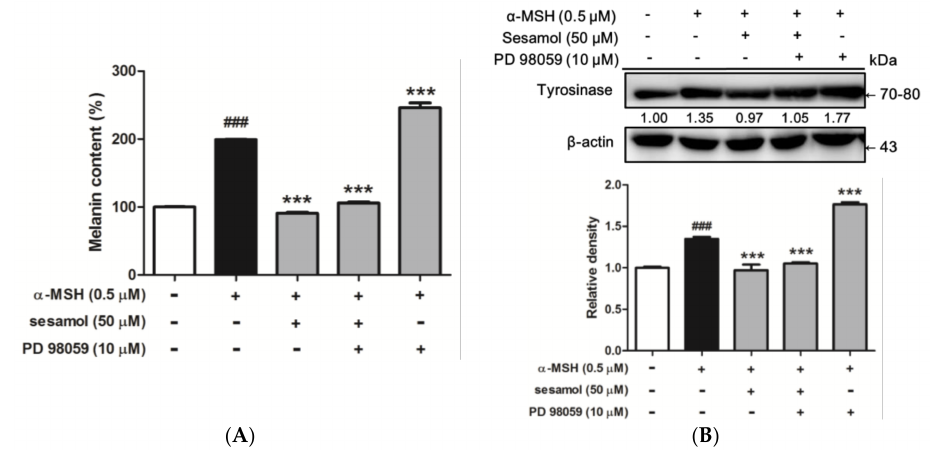
Figure 8. ( A ) Effects of sesamol and PD 98059 (ERK inhibitor) on melanin content (%) in α -MSH-treated B16F10 cells after 48 h. Each value is presented as the mean ± SD. ### p < 0.001 (Significant difference versus control); *** p < 0.001 (Significant difference versus α -MSH treated group). ( B ) Effects of sesamol and PD 98059 (ERK inhibitor) on protein expression of tyrosinase in α -MSH-treated B16F10 cells